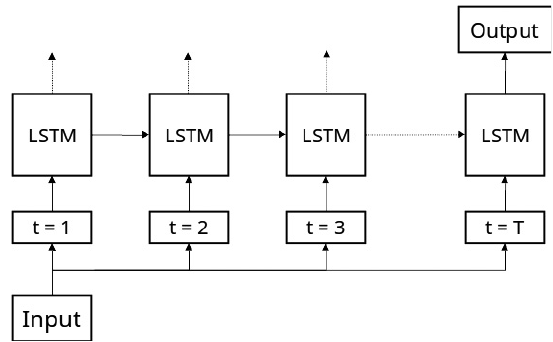
Fig. 3. A high-level overview of LSTM